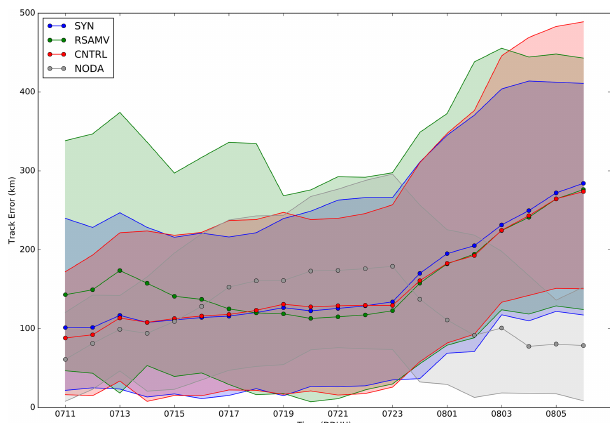
Figure 12. Ensemble mean (solid lines) and ensemble spread (shaded areas) of track error (km) associated with NODA_0700, SYN, RSAMV and CNTRL experiments from 11:00UTC, 7 November, to 12:00UTC, 8 November